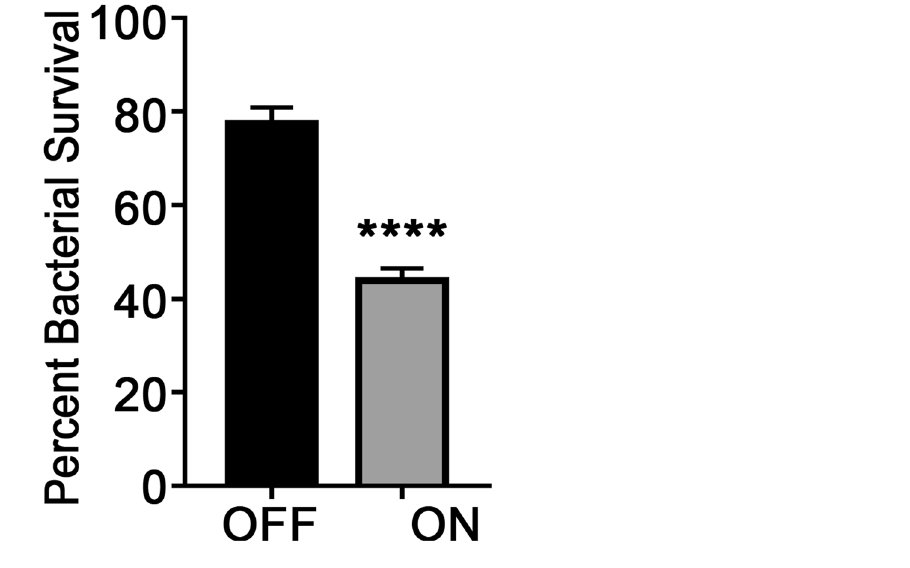
Figure 1. The modA2 locked ON variant was more sensitive to killing due to H 2 O 2 than the modA2 locked OFF variant. modA2 locked ON and modA2 locked OFF were exposed to 1 mM H 2 O 2 for 10 min and survival